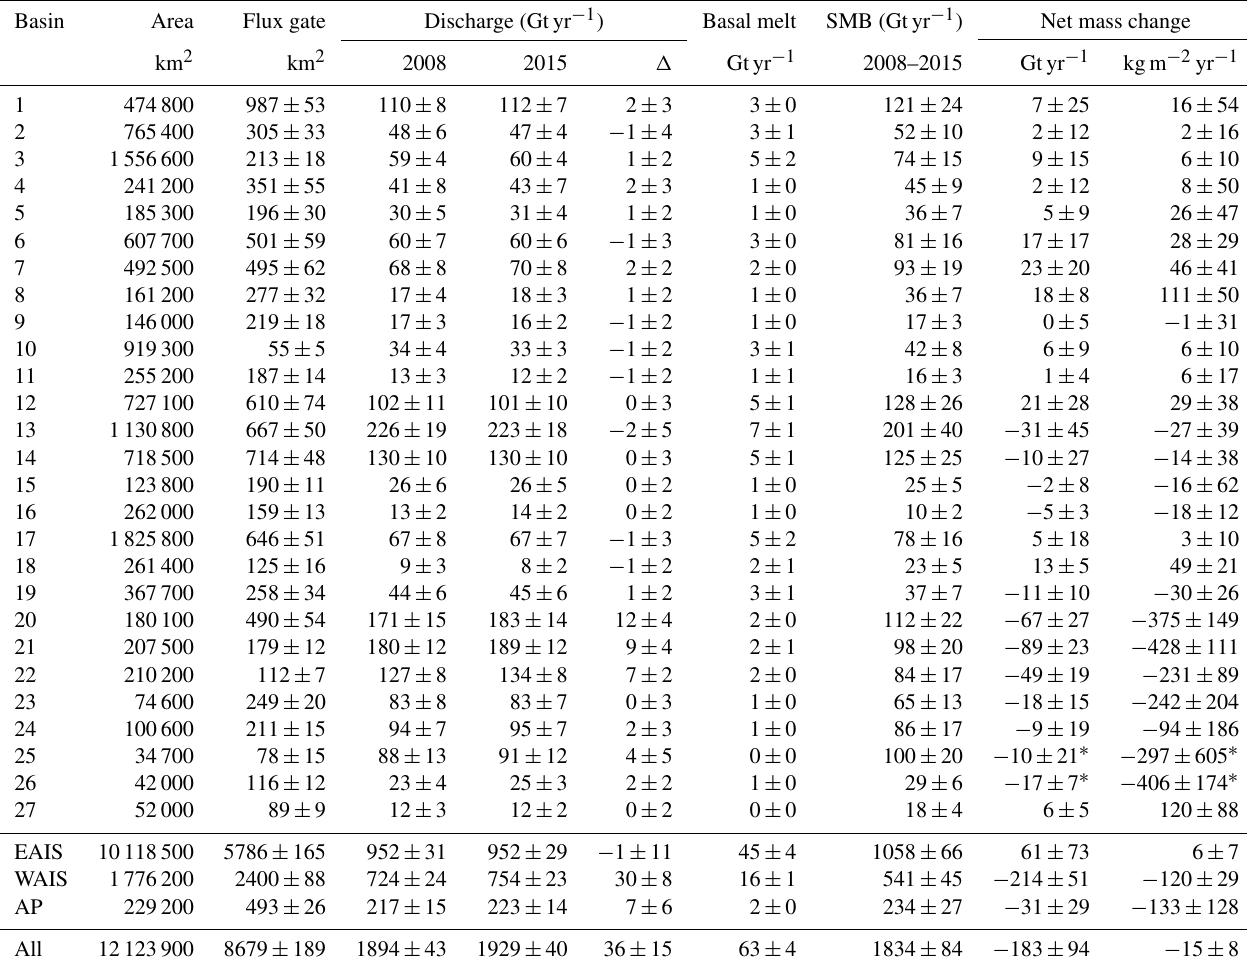
Table 2. Surface area, cross sectional area for flux gate FG2, discharge corrected for dynamic volume change and surface mass balance between flux gate FG2 and the grounding line, basal melting, surface mass balance (SMB) and net mass balance for the 27 basins defined by Zwally et al. (2002). Cumulative numbers are provided for the East Antarctic Ice Sheet (EAIS: B2–17), the West Antarctic Ice Sheet (WAIS: B1, B18–23) and the Antarctic Peninsula (AP: B24–B27). Basal melt rates are from Van Liefferinge and Pattyn (2013) and